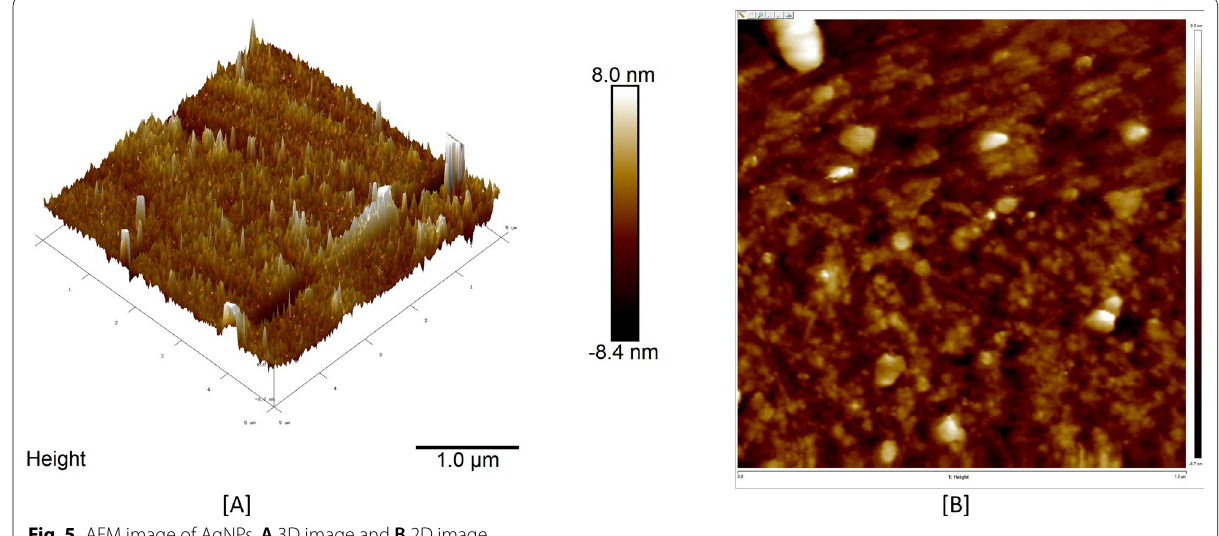
Fig. 5 AFM image of AgNPs. A 3D image and B 2D image